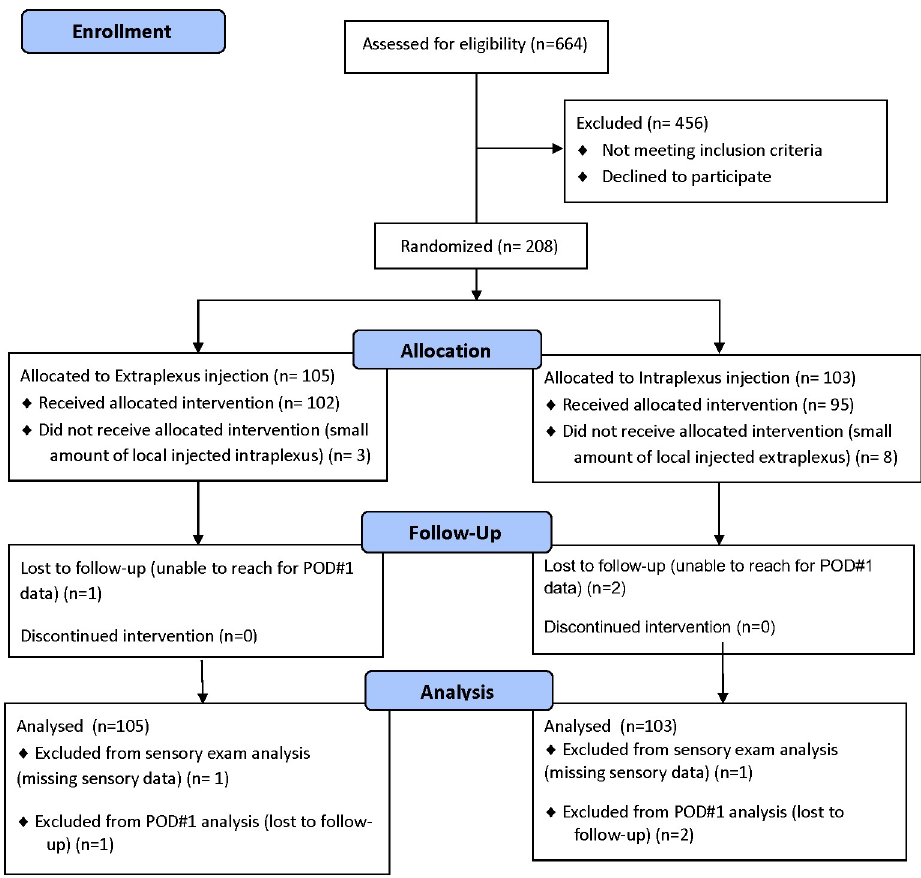
Fig 1. CONSORT diagram of patient recruitment.